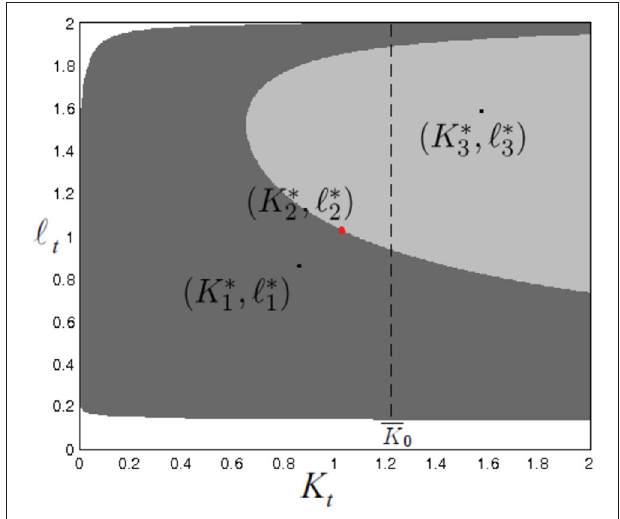
FIGURE 11 | Figure reproduced with the permission of the publisher. Source: [ 18]. Global indeterminacy ( ρ = 3.2): two attracting fixed points, ( K * 1 , l * 1 ) and